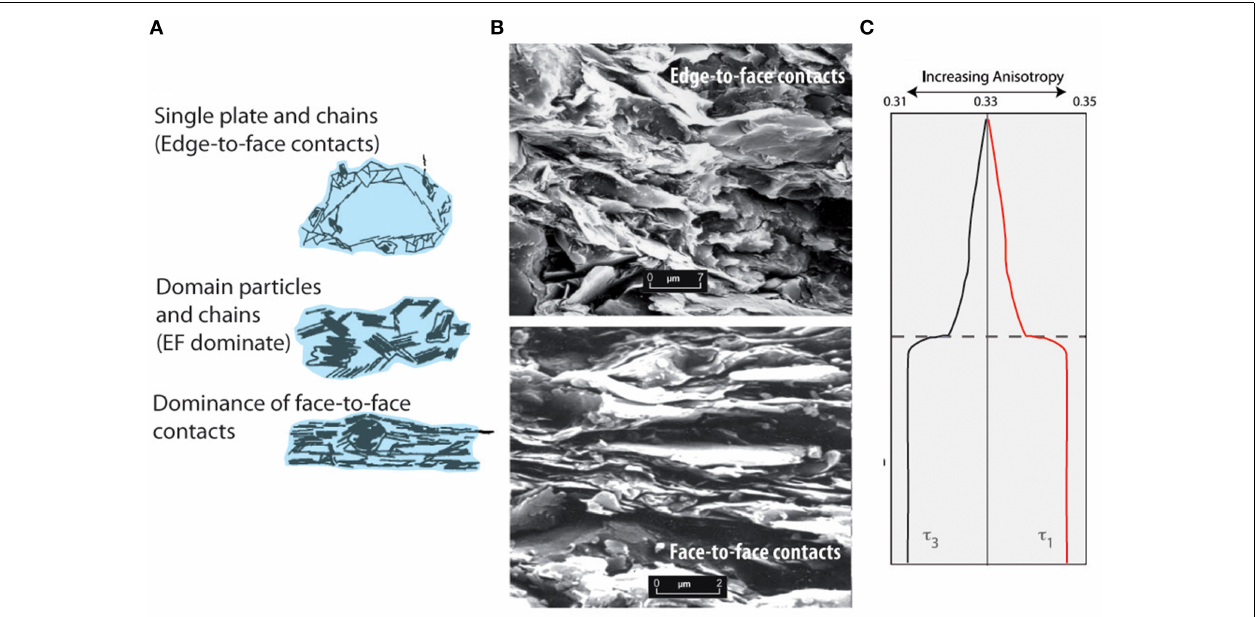
FIGURE 3 | Progressive change of clay microstructure during burial process. (A) The contact between particles changes from high-angle EF (edge-to-face) to low-angle EF and FF contact compaction. Particles slide and rotate normal to the maximum stress direction (modified from Bennett et al., 1991). (B) Example of mudstone compaction fabrics. Photo on top shows a weakly oriented clay assemblage, with open pore structure dominated by EF